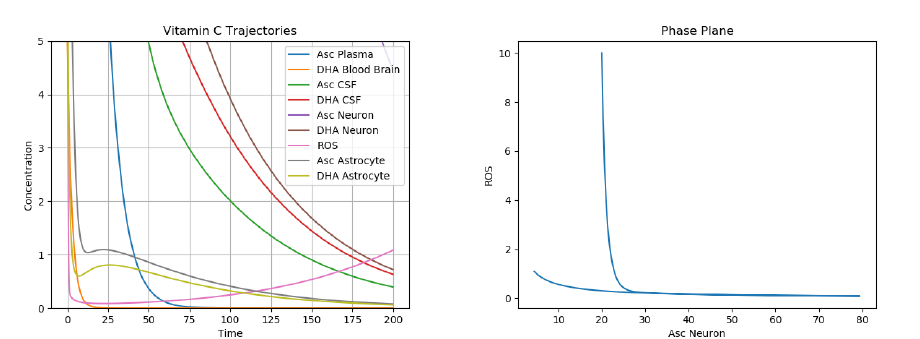
Figure 9. Dynamics of AA, DHA, and ROS in AD with Reduced Synaptic